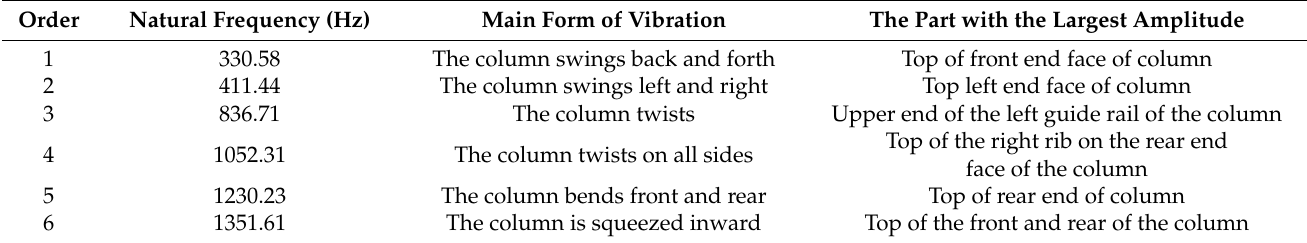
Table 4. Modal characteristics of separate